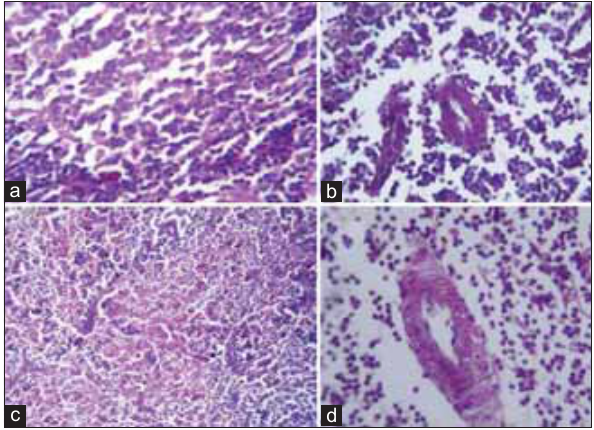
Figure-3: (a) Enlargement of the kidneys in 200 mg/kg group, (b) Moderate degree of degeneration and necrotic changes in proximal and distal convoluted tubule in the rats of 25 mg/kg group, (c) In rats of 100 mg/kg group showed congestion, hemorrhages and necrosed tubules, (d) Rats of 200 mg/kg group revealed complete lyses leaving reticular